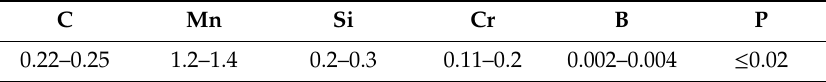
Table 2. Chemical composition of the 22MnB5 steel